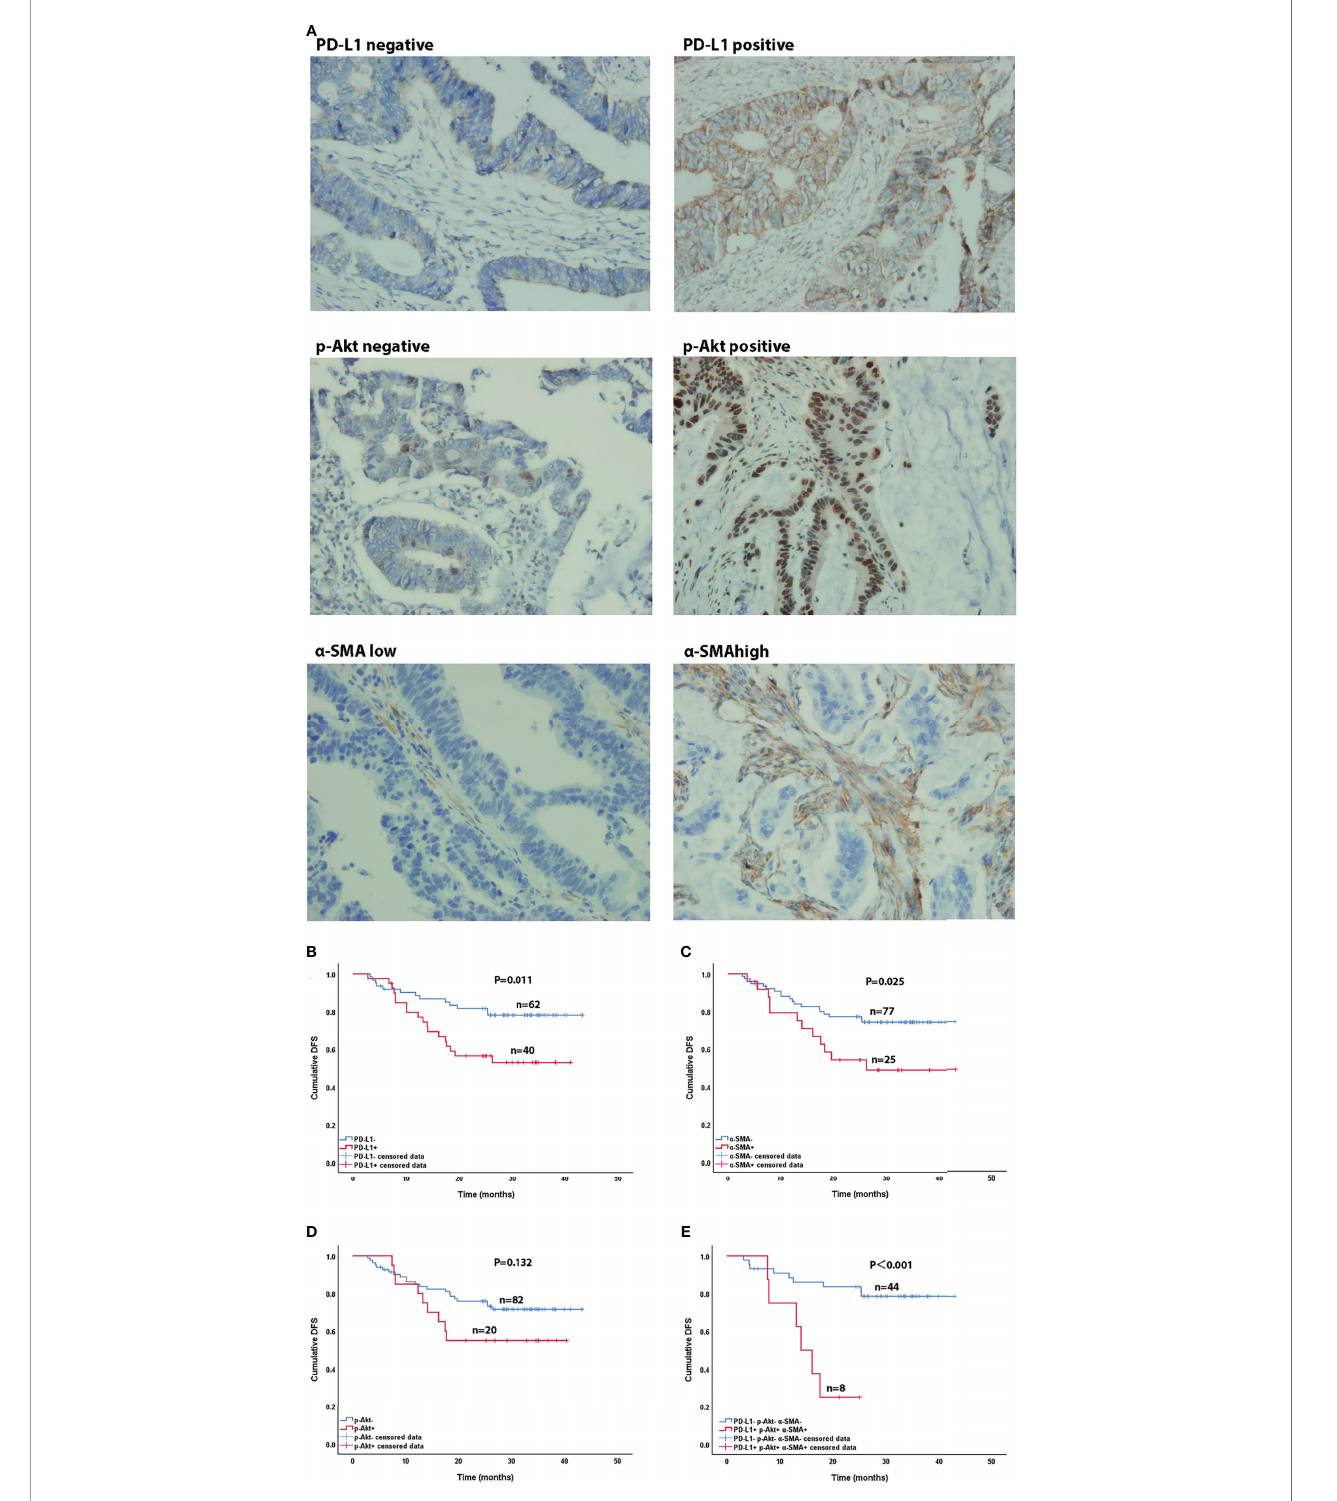
FIGURE 4 | Immunohistochemical (×400) and Kaplan-Meier curves of CRC patients. (A) Immunohistochemical staining of PD-L1, p-AKT and a -SMA expression. (B – D) Effect of PD-L1 expression (B) , p-AKT expression (C) , and a -SMA high expression (D) on DFS in CRC patients. (E) Effect of co-expression of PD-L1, p-AKT and a -SMA high and triple-negative expression on DFS in CRC